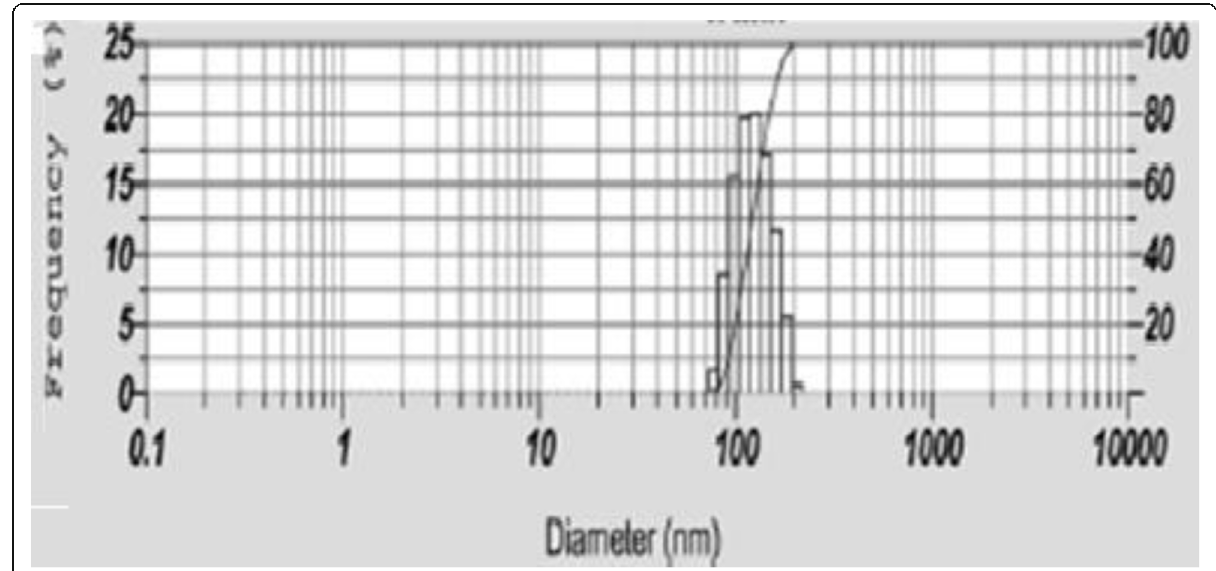
Fig. 6 Particle size graph of the OCNIG, particle size: 125.3 nm